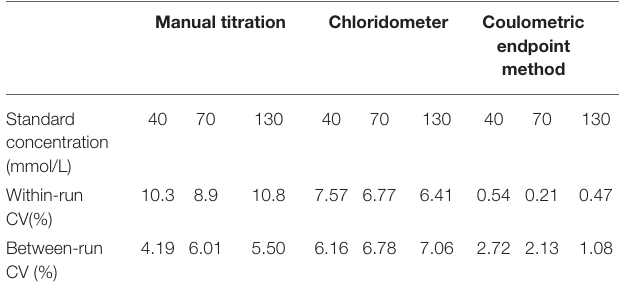
TABLE 1 | Precision studies of the assays with 40, 70, 130 mmol/L